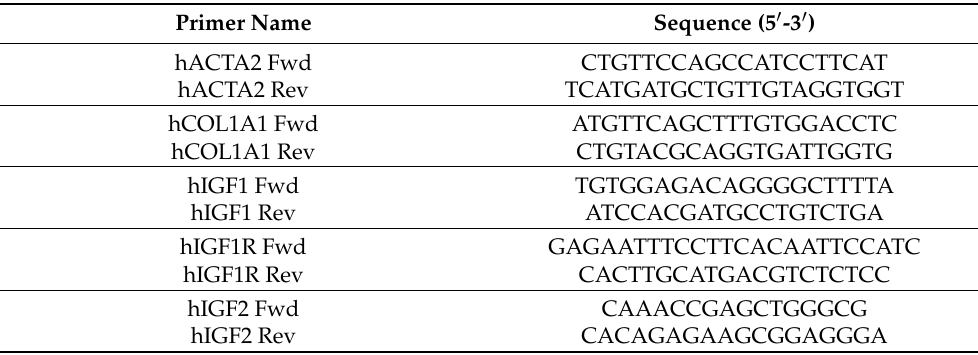
Table 1. Primers used for